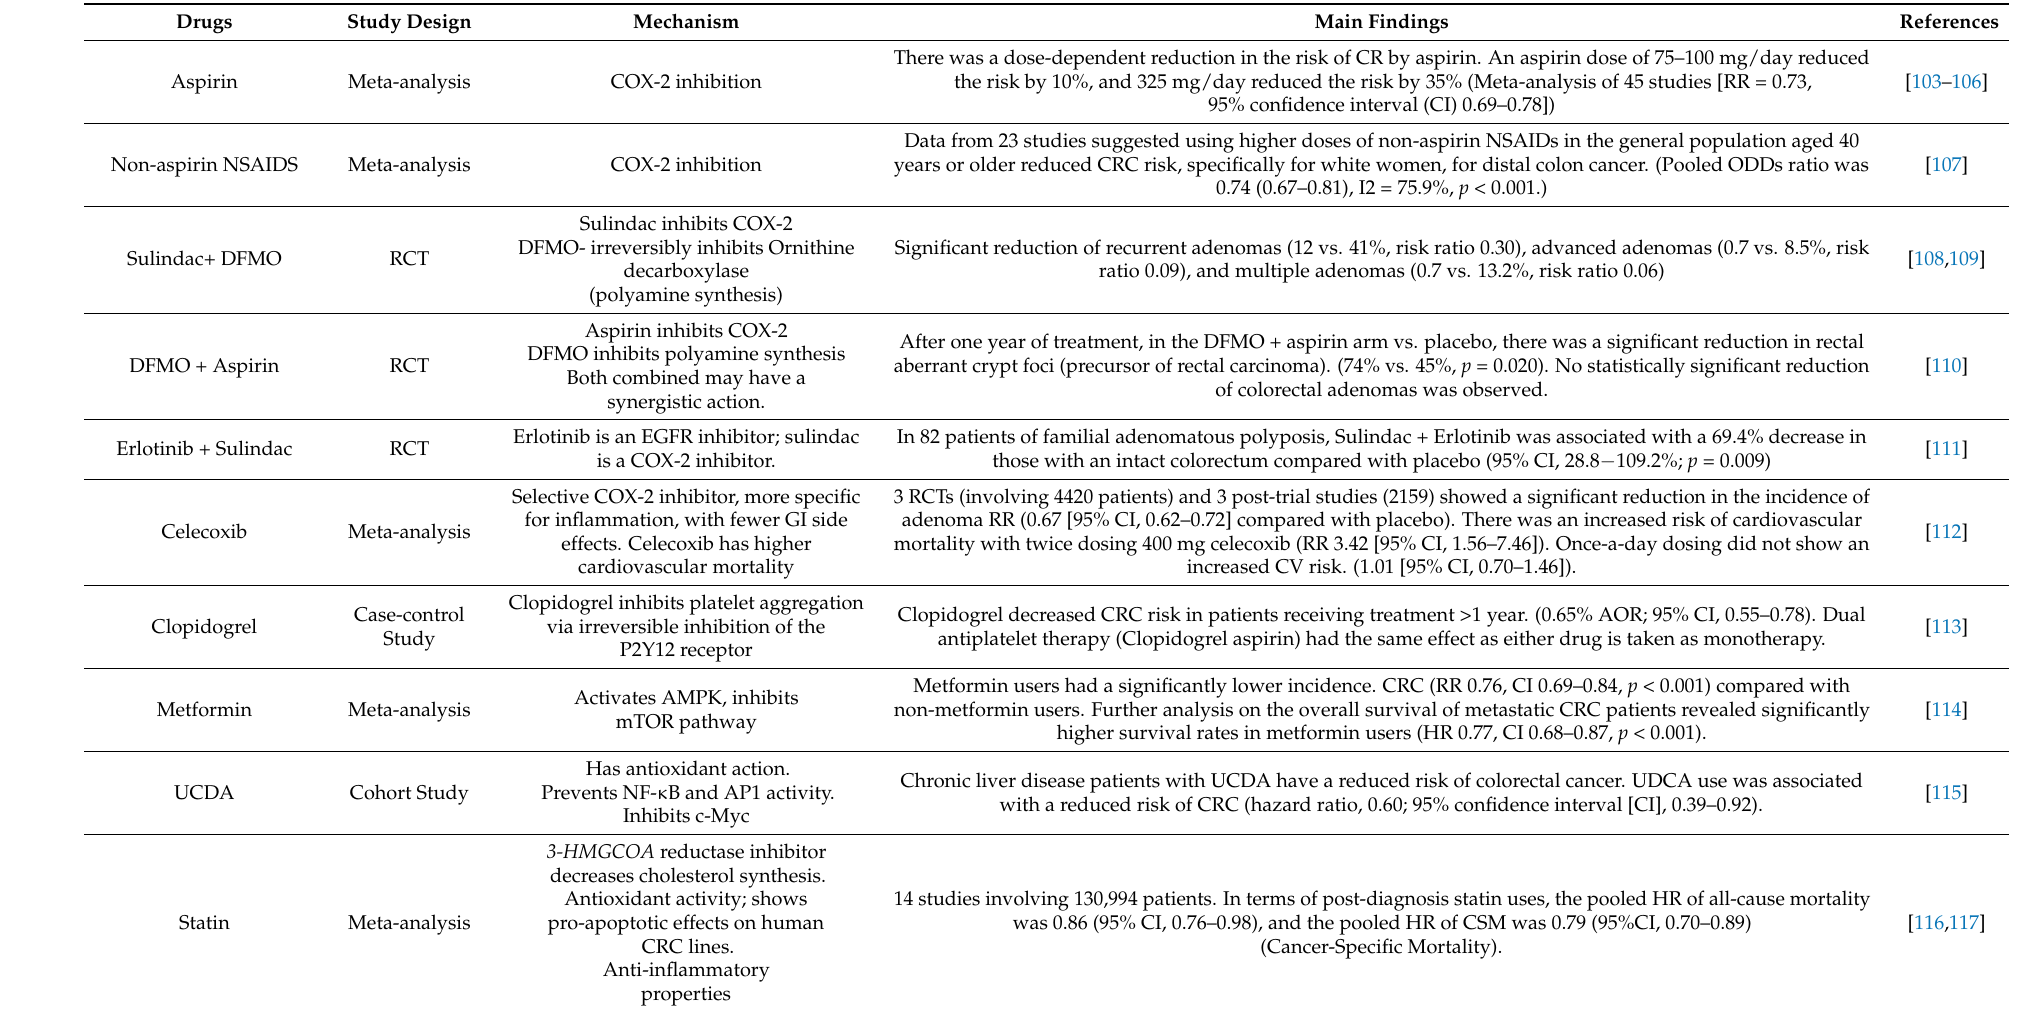
Table 2. Various drugs alone and in combination tested for their effects on clinical CRC chemoprevention